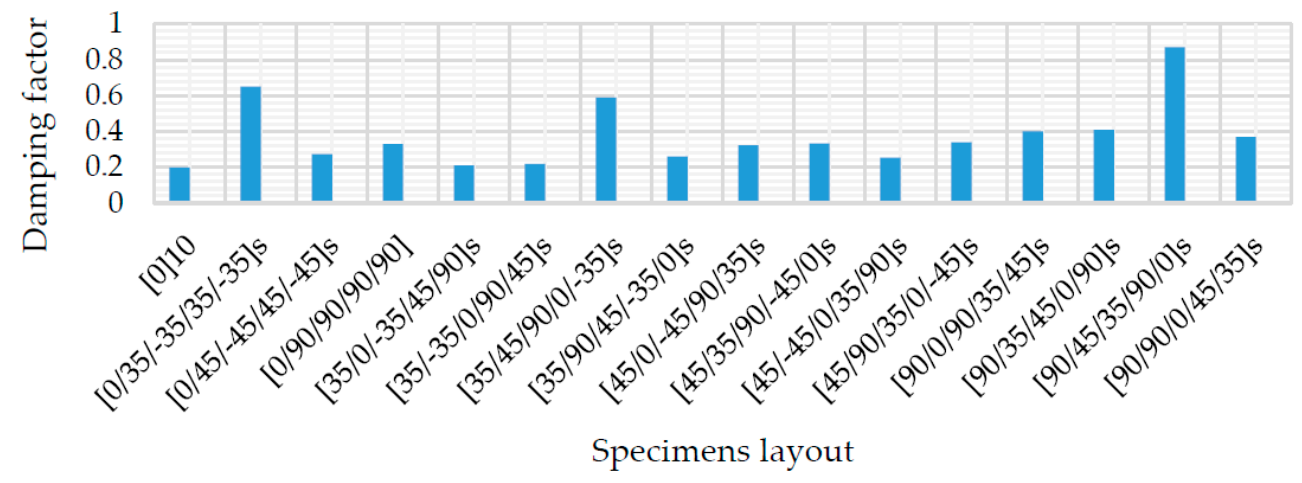
Figure 5. Variation of damping factors with stacking sequences and fiber orientations.